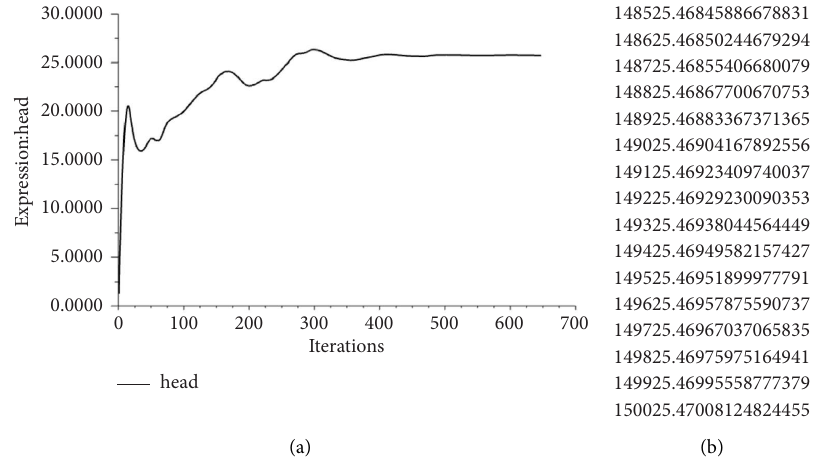
Figure 5: Diagram of head simulation. (a) Head curve diagram. (b) Head monitoring documentation